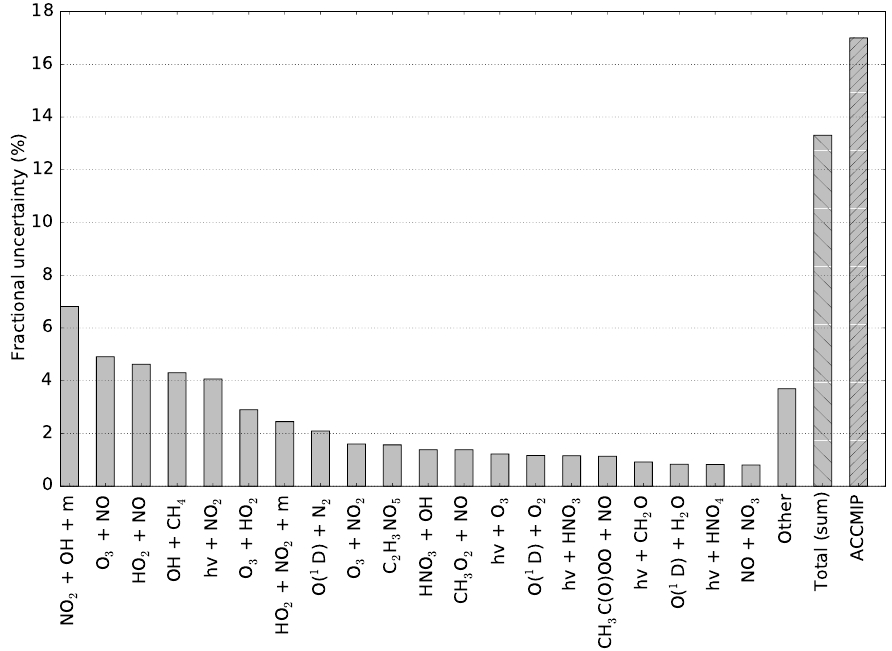
Figure 15. Uncertainties in O 3 radiative forcing: absolute fractional uncertainty in tropospheric O 3 radiative forcing between the pre- industrial and present-day simulations due to rate constant uncertainty. Shown on the left are the 20 most important reactions. “Other” shows the addition in quadrature of the remaining 40 reactions. “Total (sum)” indicates the total fractional uncertainty calculated by adding together the individual uncertainties in quadrature. “ACCMIP” indicates the inter-model spread found from the ACCMIP (Young et al., 2013)